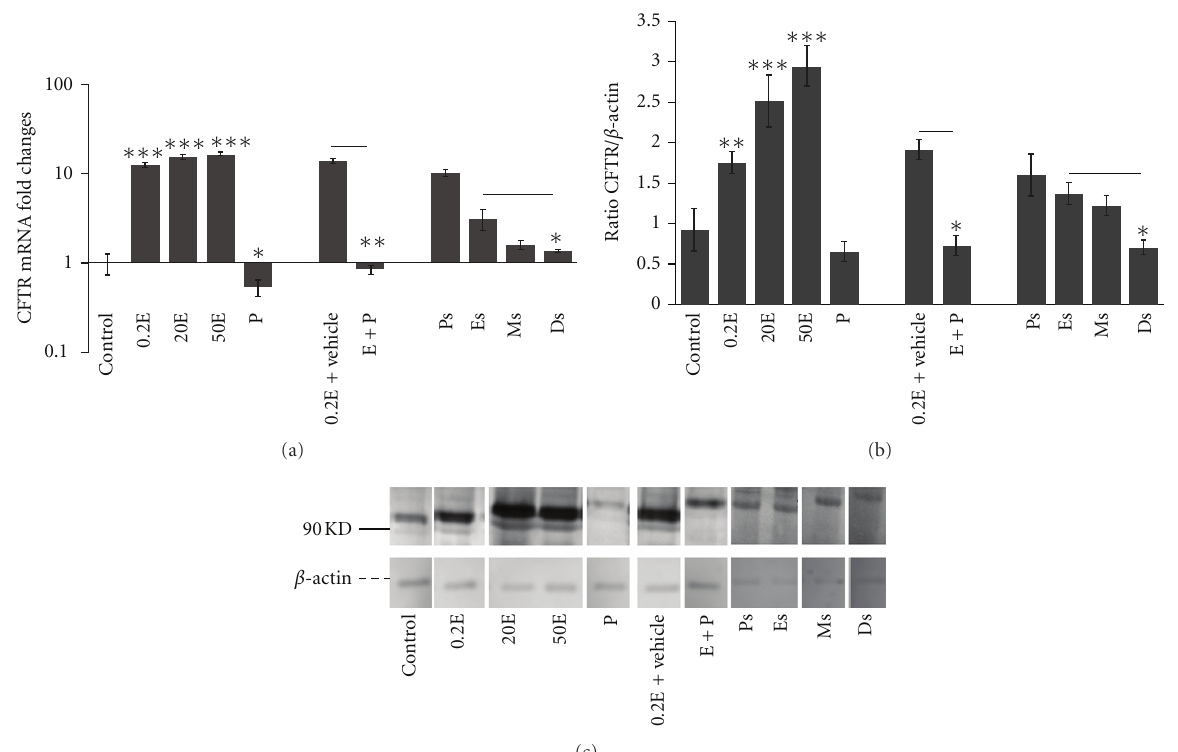
Figure 1: Real-time PCR (a) and Western blotting analysis (b) of total homogenate of the uterus; representative photo of western blots (c) of CFTR in ovariectomized rats and rats at di ff erent stages of the oestrous cycle. Results indicate that CFTR expression is oestrogen dependent. The photos as shown in (c) came from a same gel/blot that has been cut in order to arrange the di ff erent groups of treatment in sequence as to match the result in (a) and (b). Control: peanut oil, E: 0.2 μ g oestrogen, 20 E: 20 μ g oestrogen, 50 E: 50 μ g oestrogen, P: progesterone, E + vehicle: 0.2 μ g oestrogen + peanut oil E + P: 0.2 μ g oestrogen + progesterone. Ps: proestrus, Es: estrus, Ms: metestrus, Ds: diestrus: ∗ P < 0 . 05, ∗∗ P < 0 . 01, ∗∗∗ P < 0 .